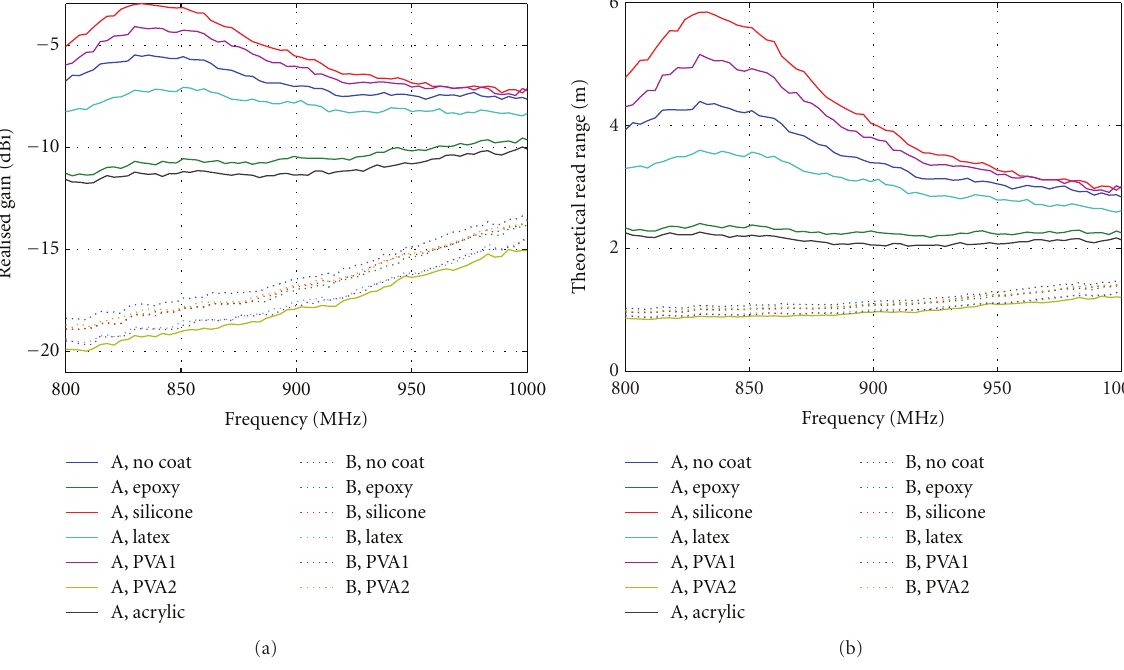
Figure 4: Frequency responses of the dry tags, expressed as realised gain as well as theoretical read range. All the tags on fabric (B) operate poorly because of the broken t-matching